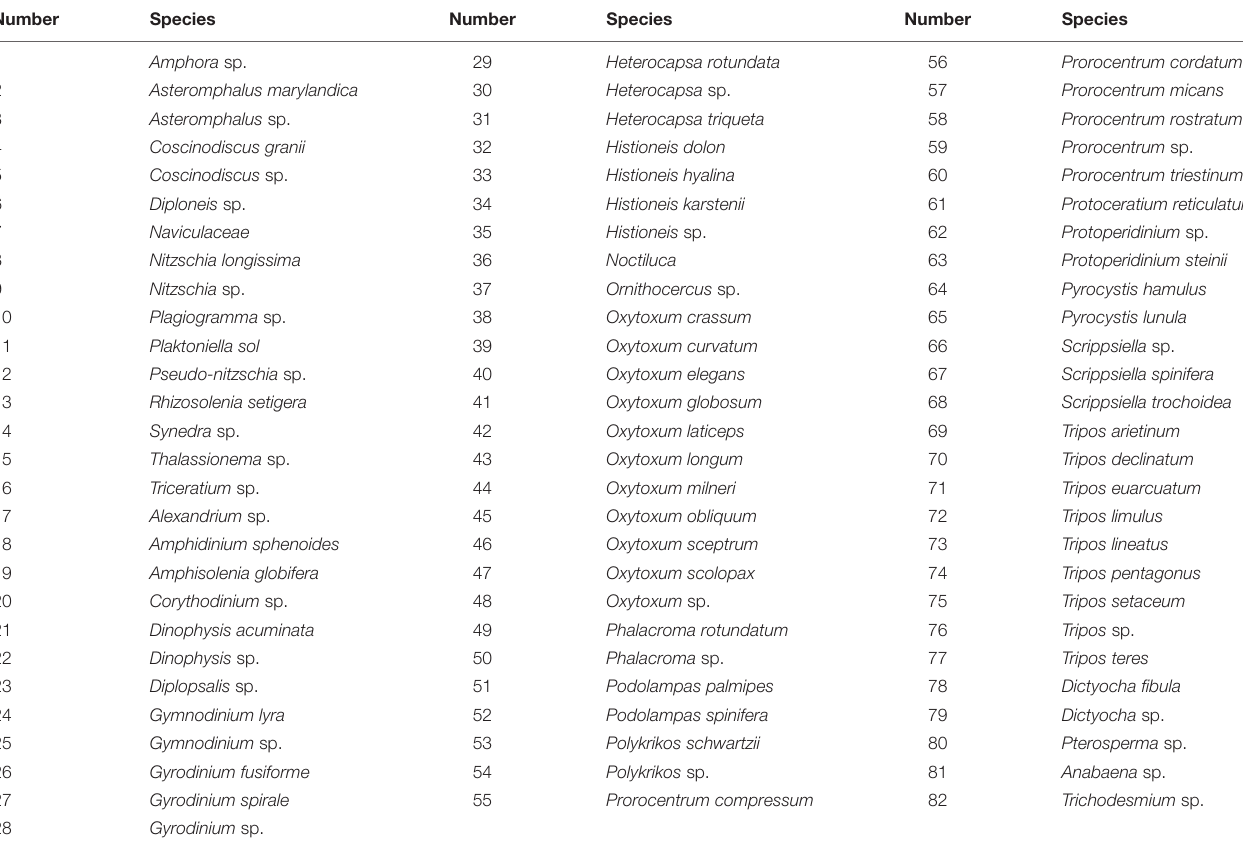
TABLE 5 | Species found in the 3 eddies used in the CCA in comparison with the environmental variables ( Figure 6A ). Number Species